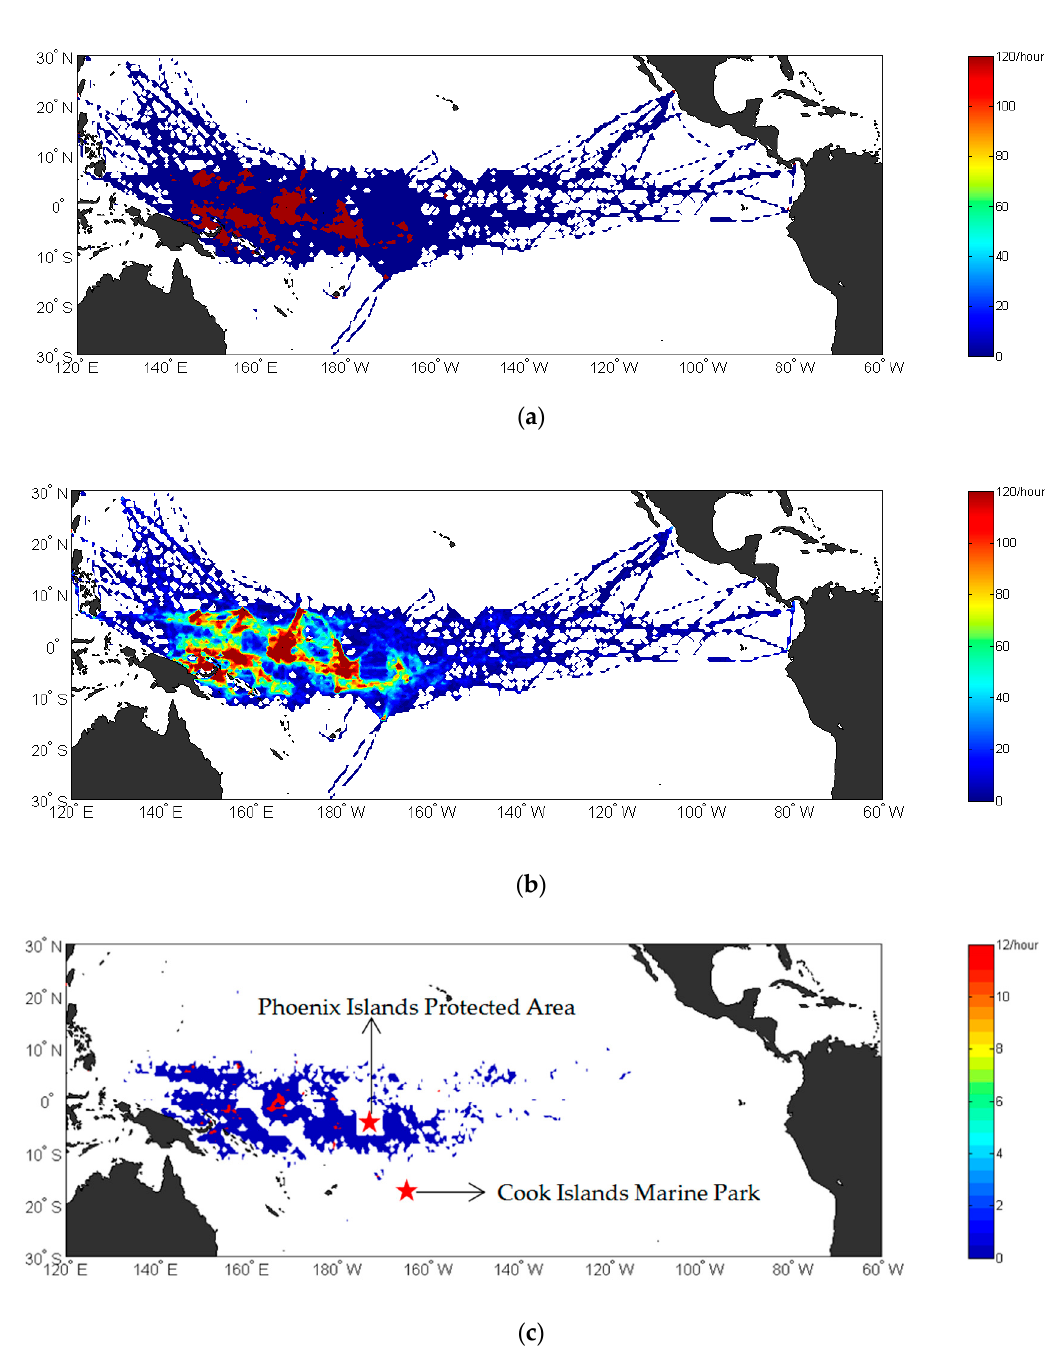
Figure 6. Overall spatial distribution of fishing effort: ( a ) All behaviour of vessels; ( b ) high-speed transiting: looking for or chasing fish schools; ( c ) purse seine operations. ( (cid:70) : Marine Protected Area).